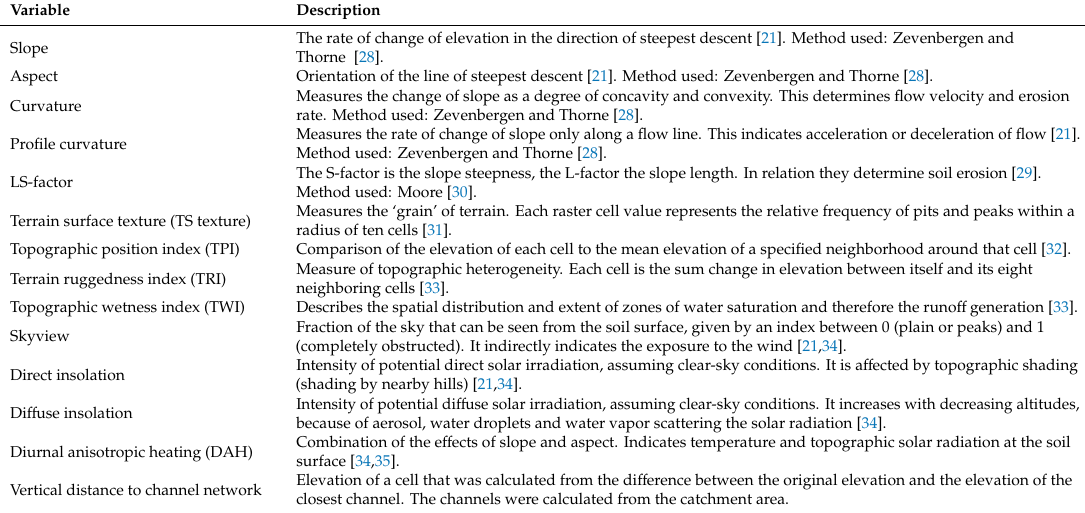
Table 1. Overview of all terrain characteristics derived from the ancient digital elevation model (DEM) using SAGA geographic information system (GIS) terrain modules. If a specified algorithm was used, it is given in the